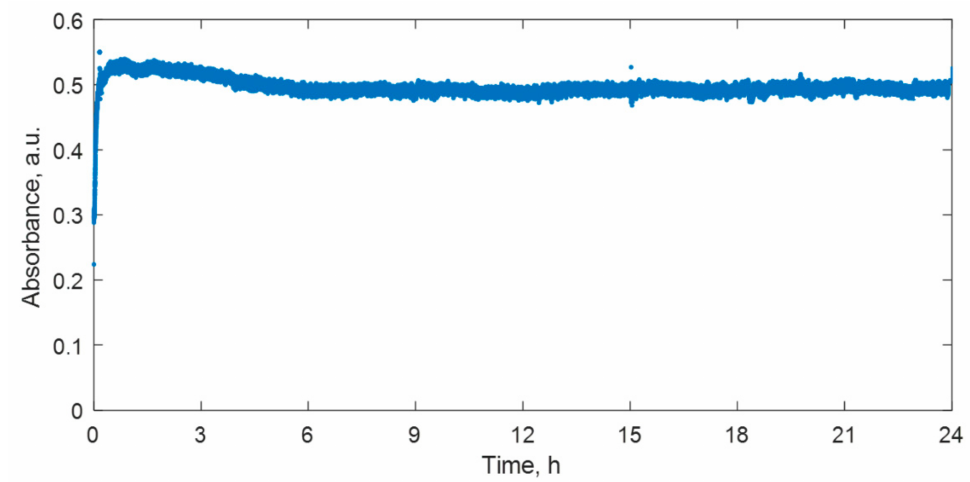
Figure 2. Variations of optical properties over 24 h in irradiated nMAG dose